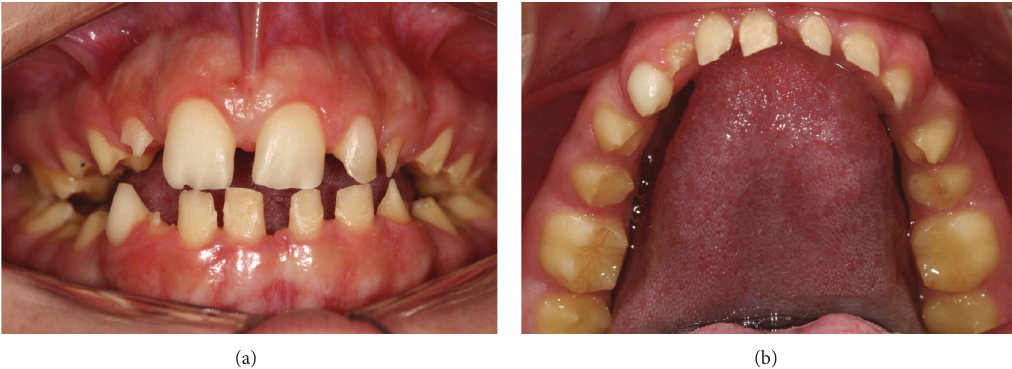
Figure 1: Initial intraoral aspect of 8-year-old patient with amelogenesis imperfecta.